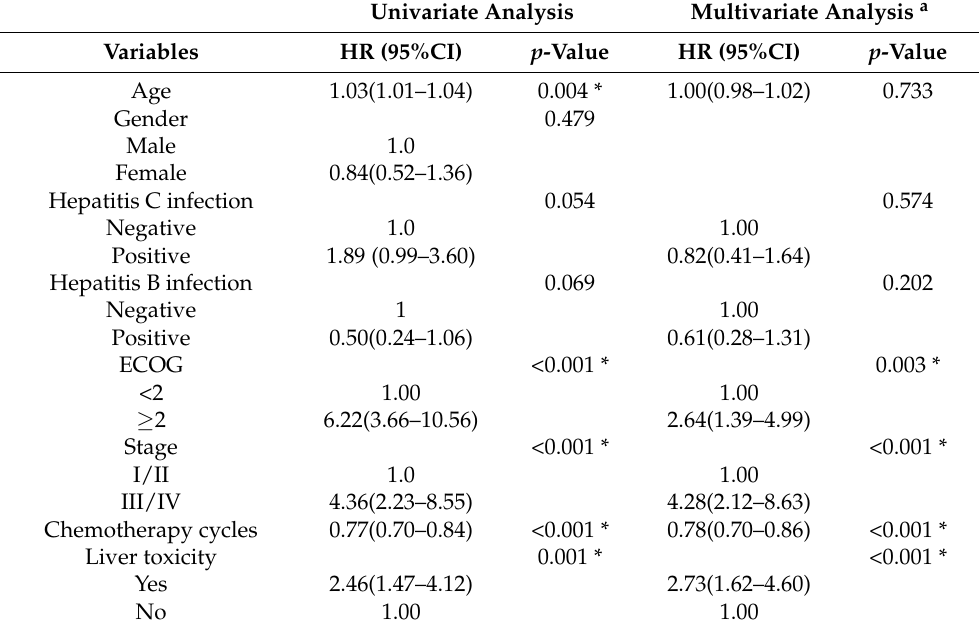
Table 3. Univariate and multivariate analysis of risk factors for overall survival. Univariate Analysis Multivariate Analysis a